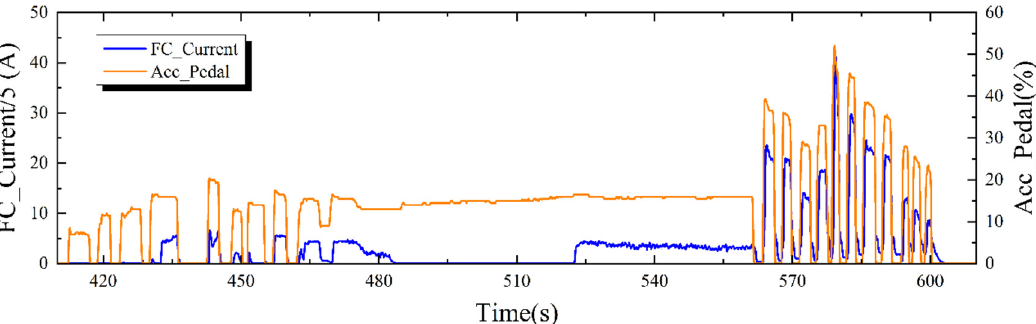
Figure 10. The output power of fuel cell stack in starting phase vs. accelerator pedal depth.